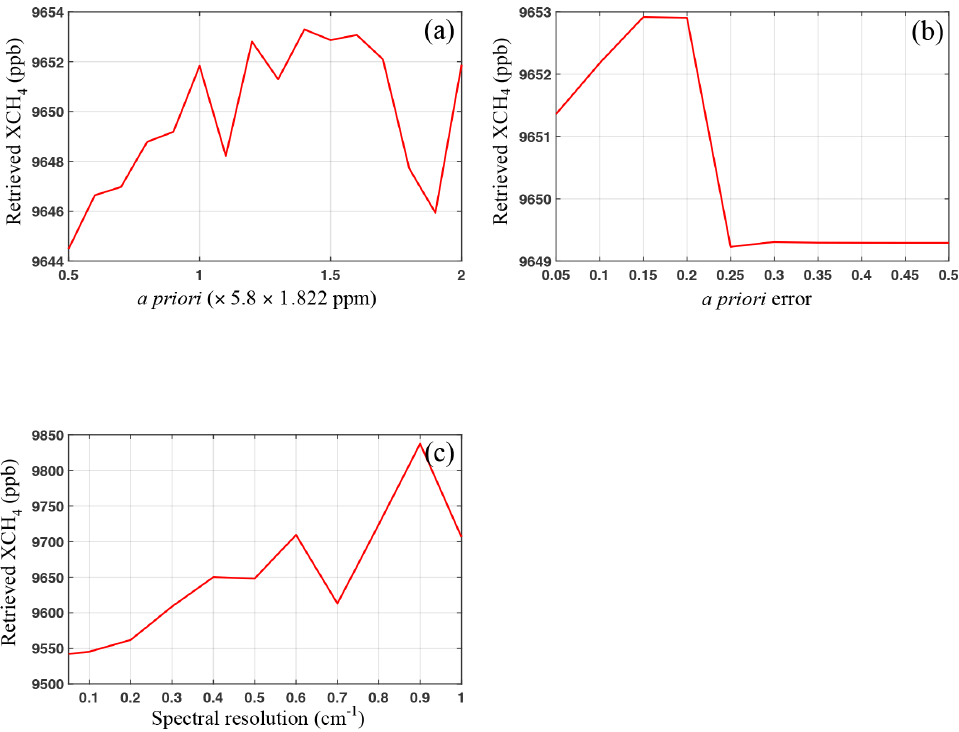
Figure 9. Retrieved XCH 4 for different values of (a) a priori (a priori error = 0 . 2), (b) a priori error (a priori = 5 . 5 × 1 . 822ppm), and